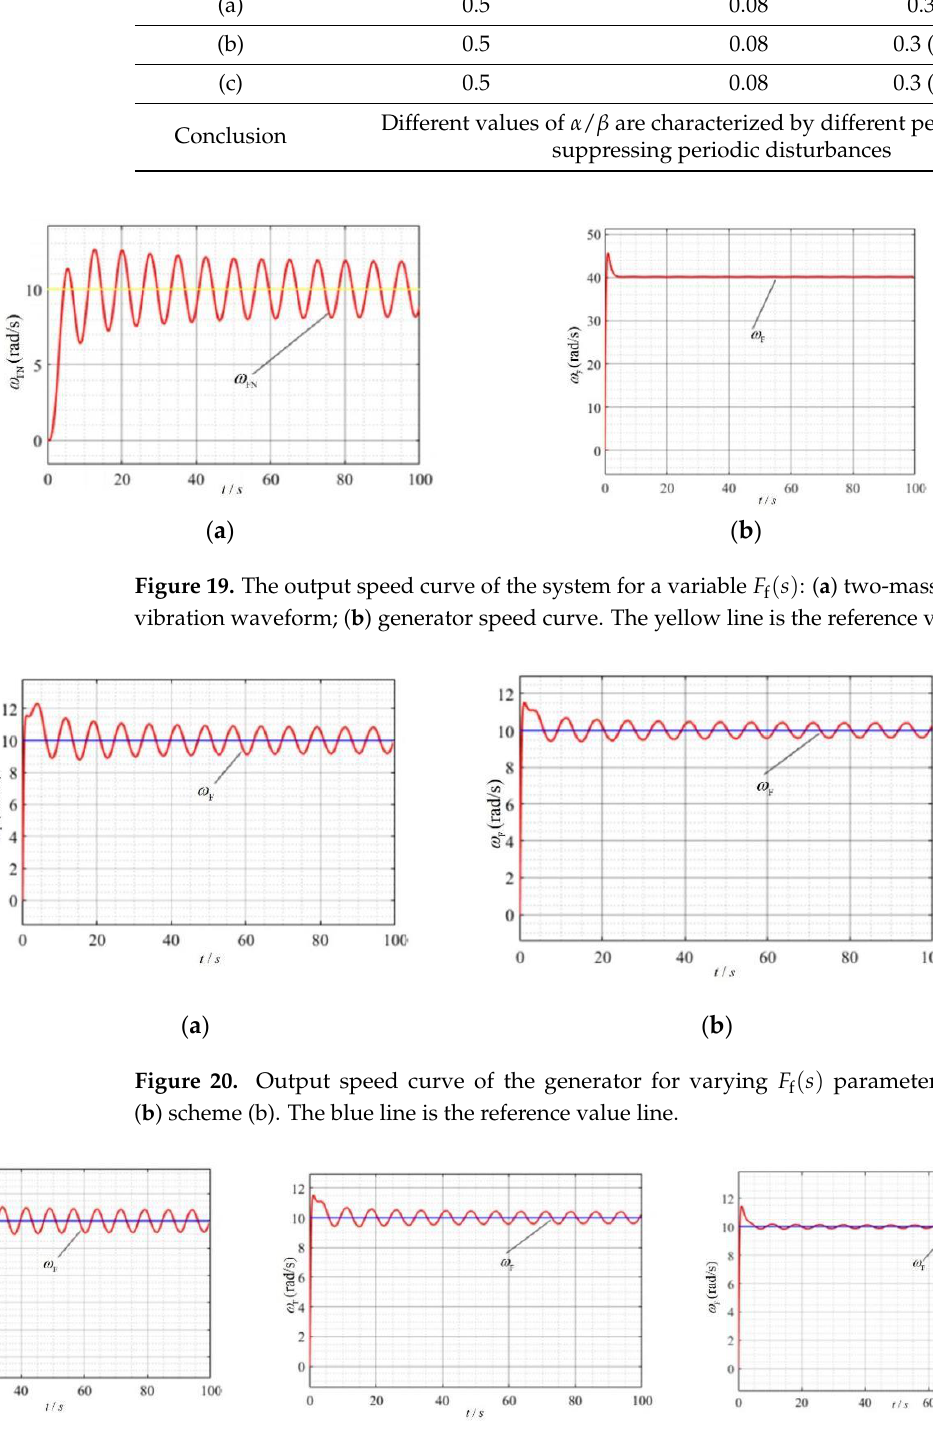
Figure 21. Output speed curve of the generator for variable 𝐹 f (𝑠) : ( a ) t scheme (a); ( b ) scheme (b); ( c ) scheme (c). The blue line is the reference value line